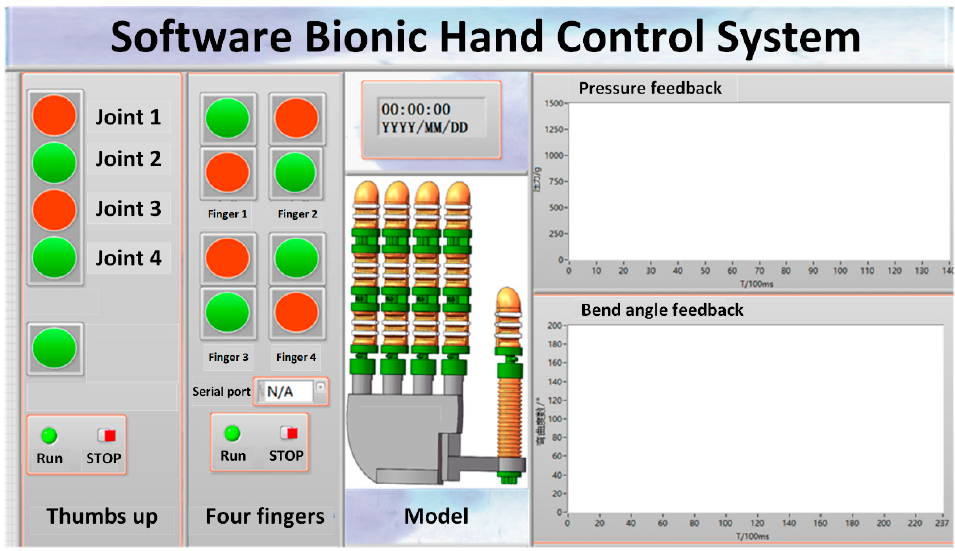
Figure 12. GUI control interface.